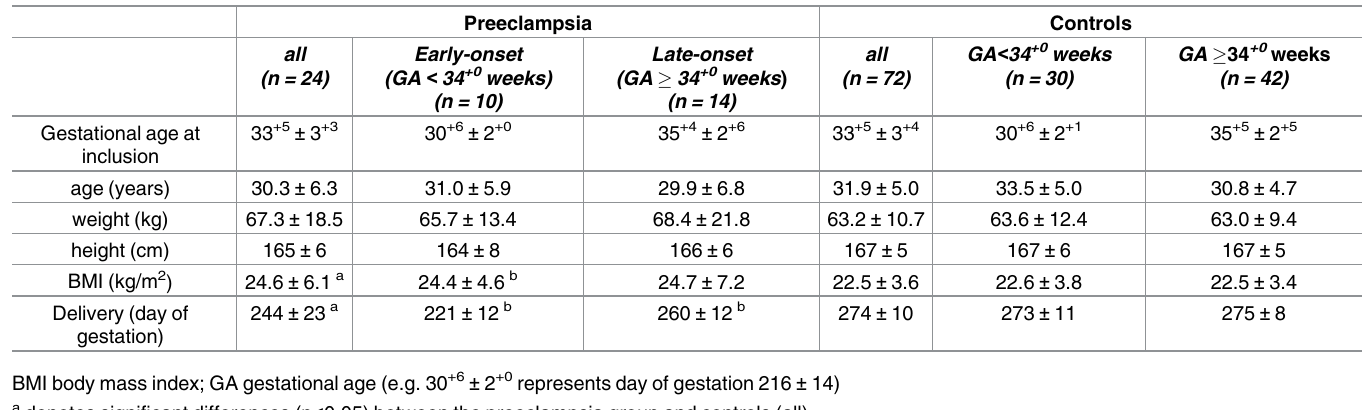
Table 1. Demographic parameters of the study population.